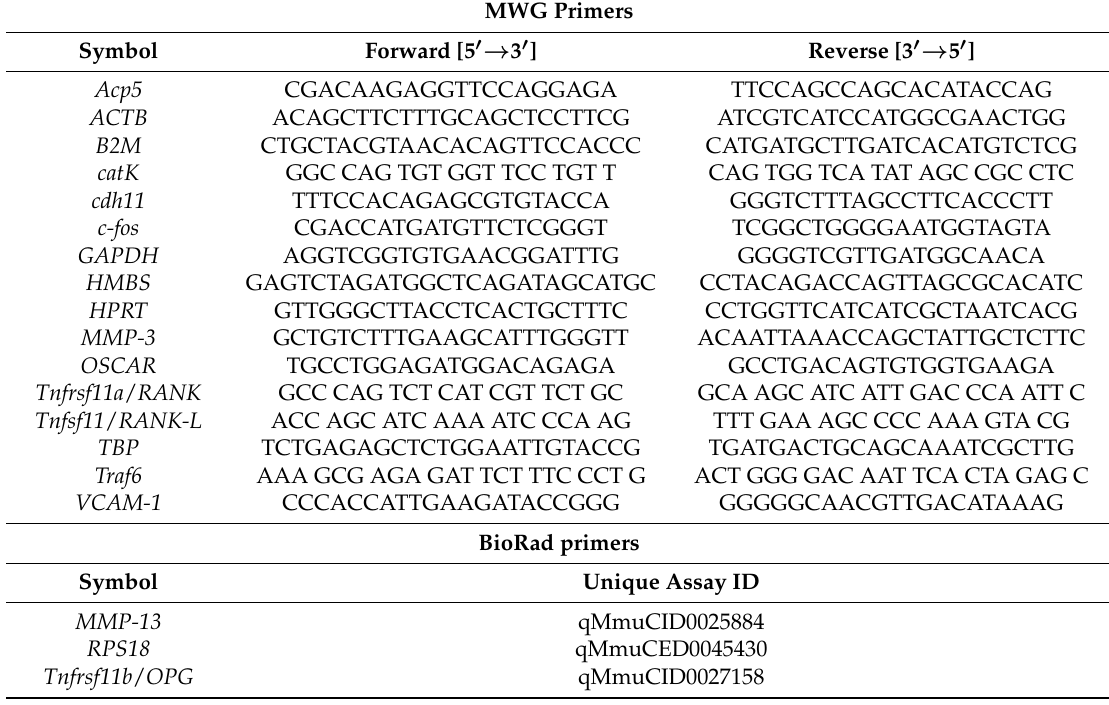
Table 1. List of used Primers and their respective sequences in alphabetic